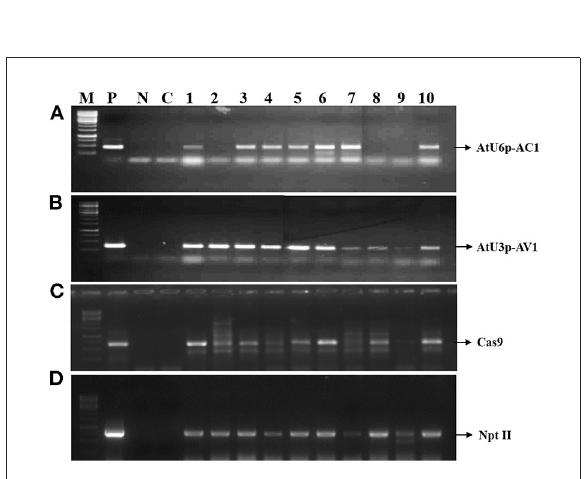
FIGURE3 Molecular confirmation of putatively transformed plants (T 0 ): the agarose gel shows the amplification of (A) AtU6p-AC1 of 480 bp, (B) AtU3p-AV1 of 420 bp, (C) Cas9 of 610 bp and, (D) npt II of 730 bp M; 1Kb ladder, P, positive control; N, negative control; C, control; Lanes 1 to 10; transformed greengram